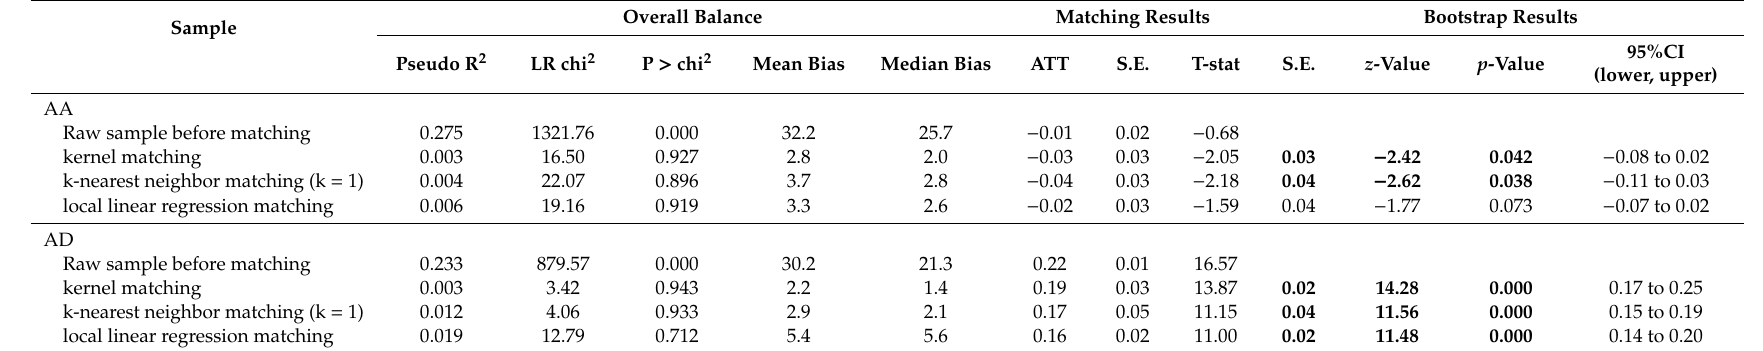
Table 5. Overall balance test and matching results from three kinds of matching